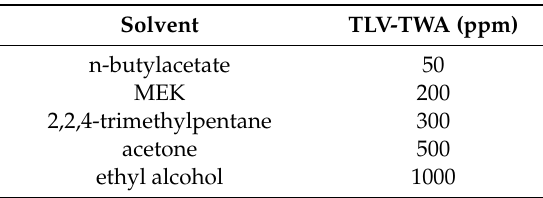
Table 1. The TLV-TWA (Threshold Limit Value-Time-Weighted Average) values expressed in ppm: a measure of the maximum amount of solvent which a worker can be safely exposed to on a daily basis for a working life (8 h / day, 40 h / week work schedule)